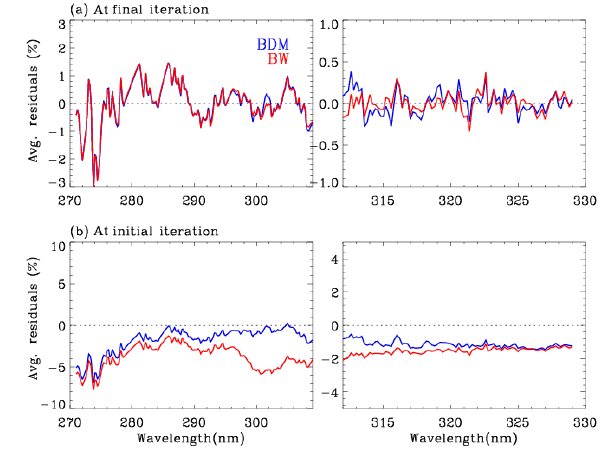
Figure 6. Comparison of mean fitting residuals at latitudes of 15 ◦ S to 15 ◦ N at (a) final iteration and (b) initial iteration, respectively, when using BDM (blue) and BW